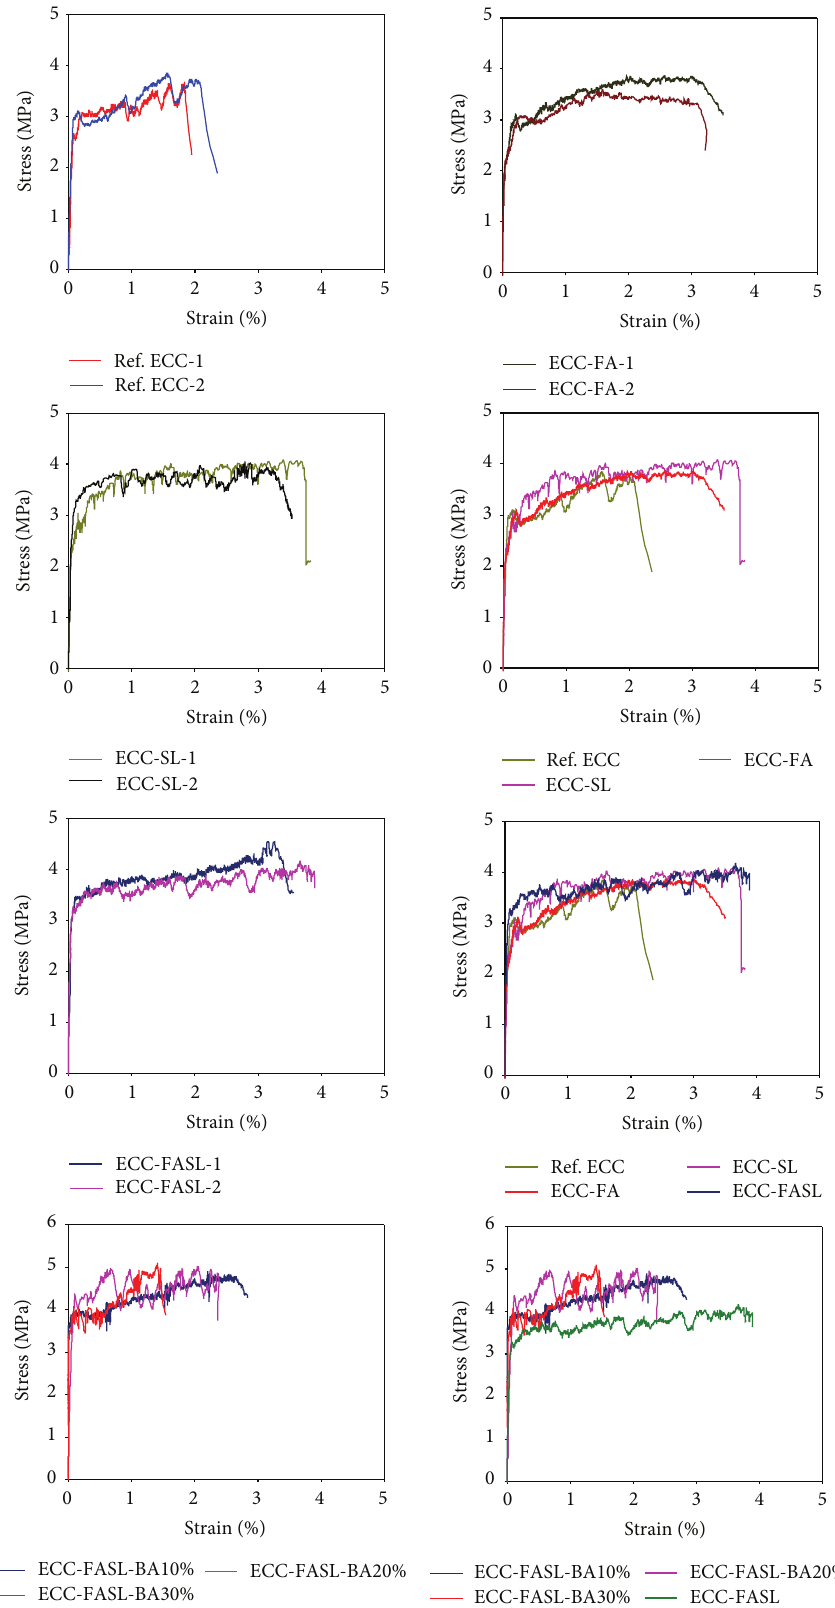
Figure 4: Uniaxial tensile stress-strain behavior of all ECC mixtures and